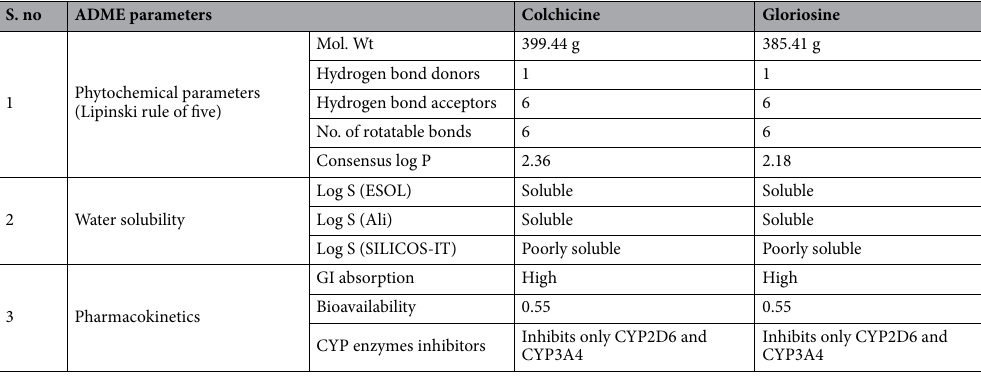
Table 1. ADME studies of colchicine and gloriosine generated by SwissADME tool.